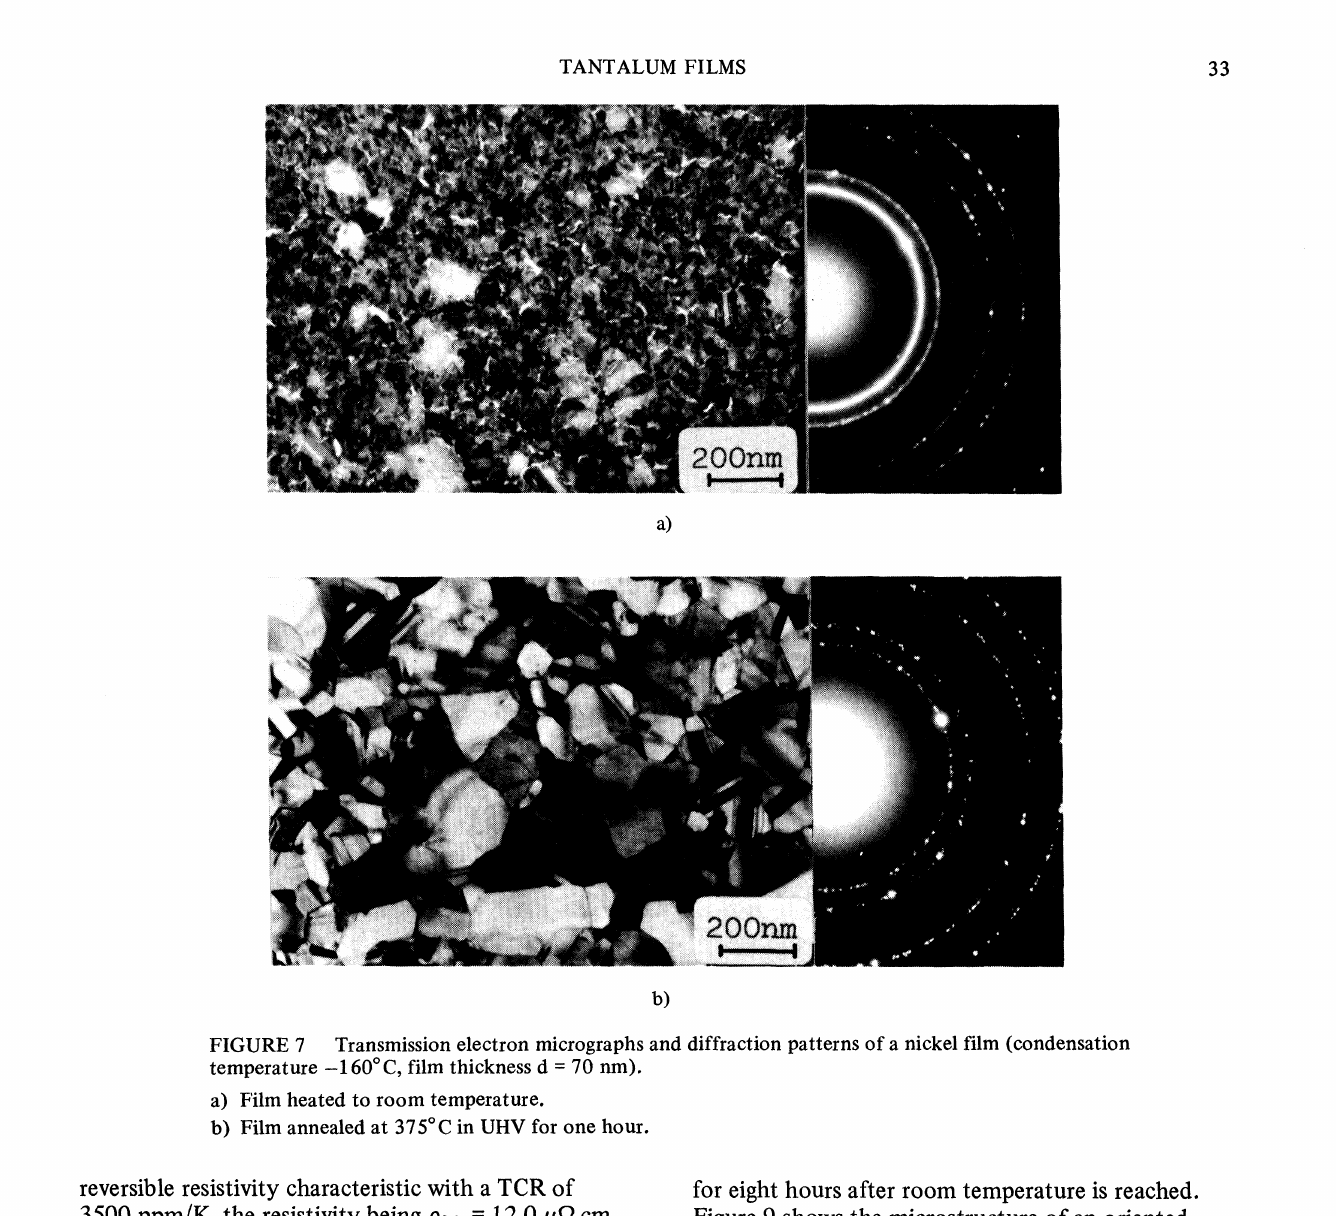
FIGURE 7 Transmission electron micrographs and diffraction patterns of a nickel film (condensation temperature -160 C, film thickness d 70 nm). a) Film heated to room